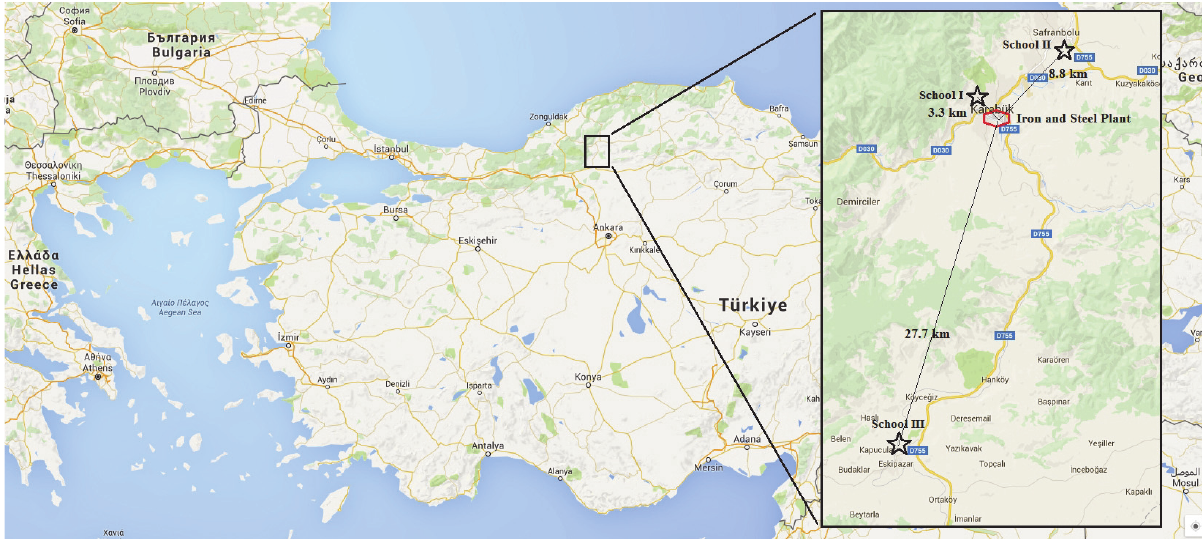
Figure 1: The location of the schools, according to the heavy industry